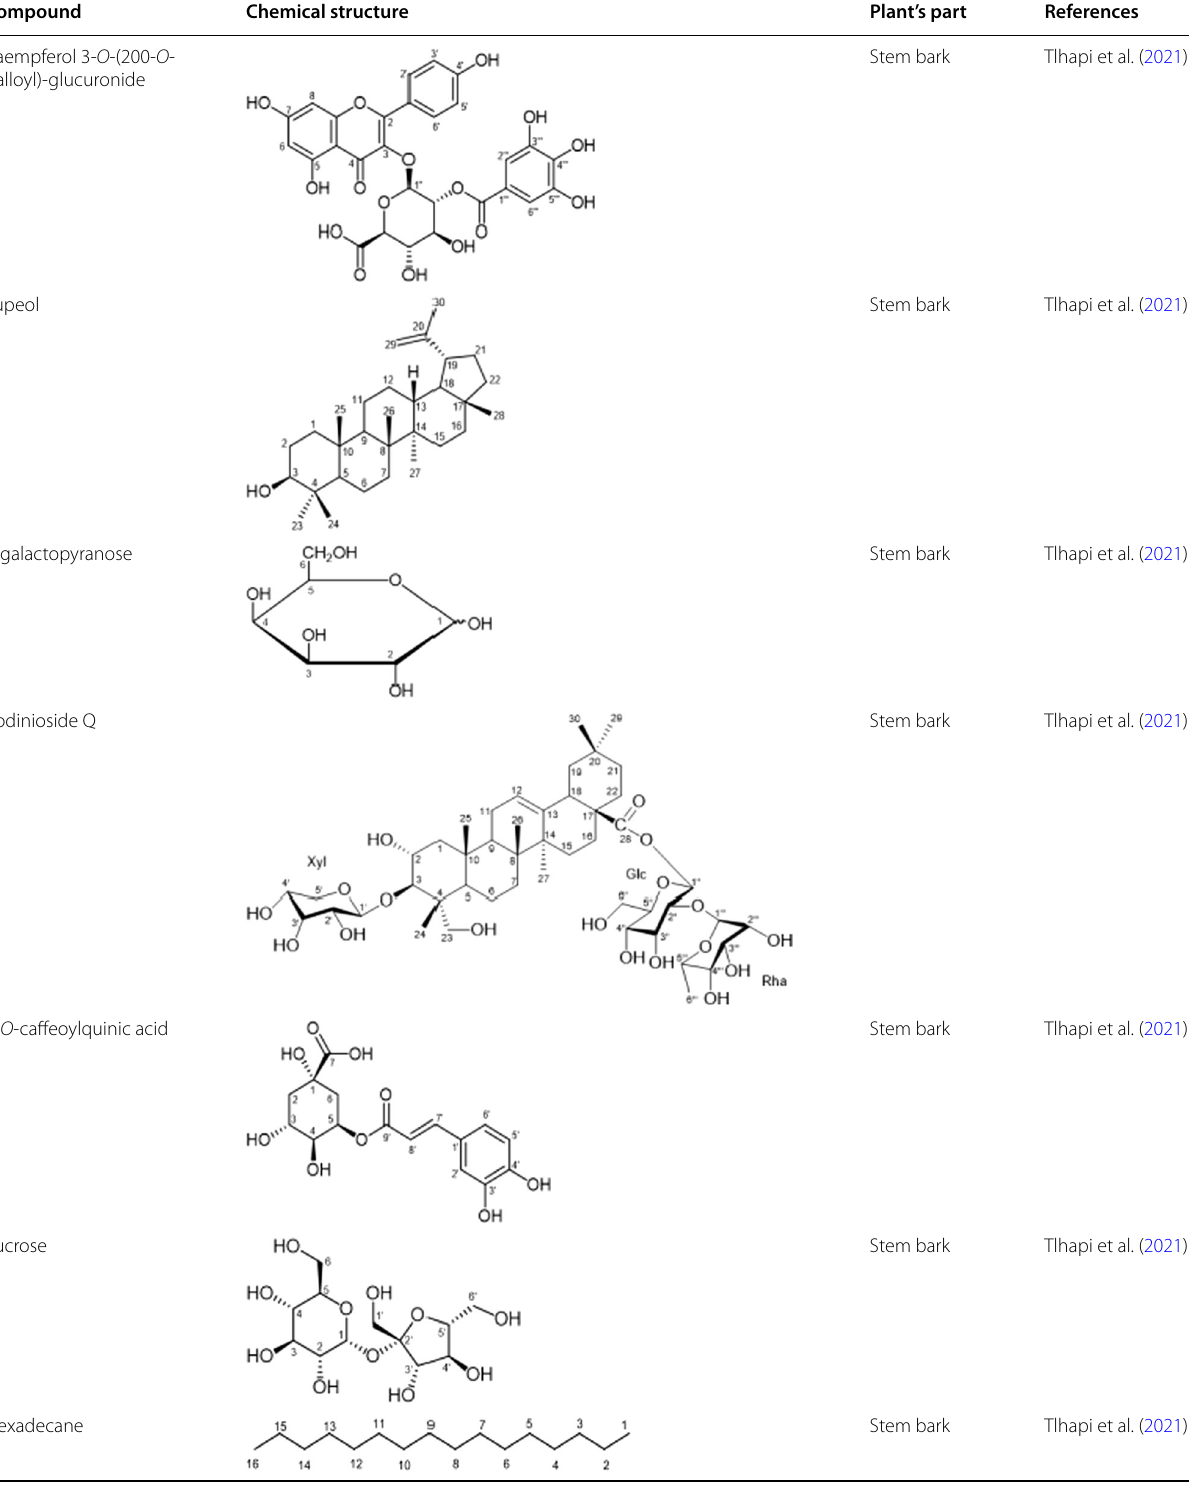
Table 3 Other compounds isolated from Breonadia salicina